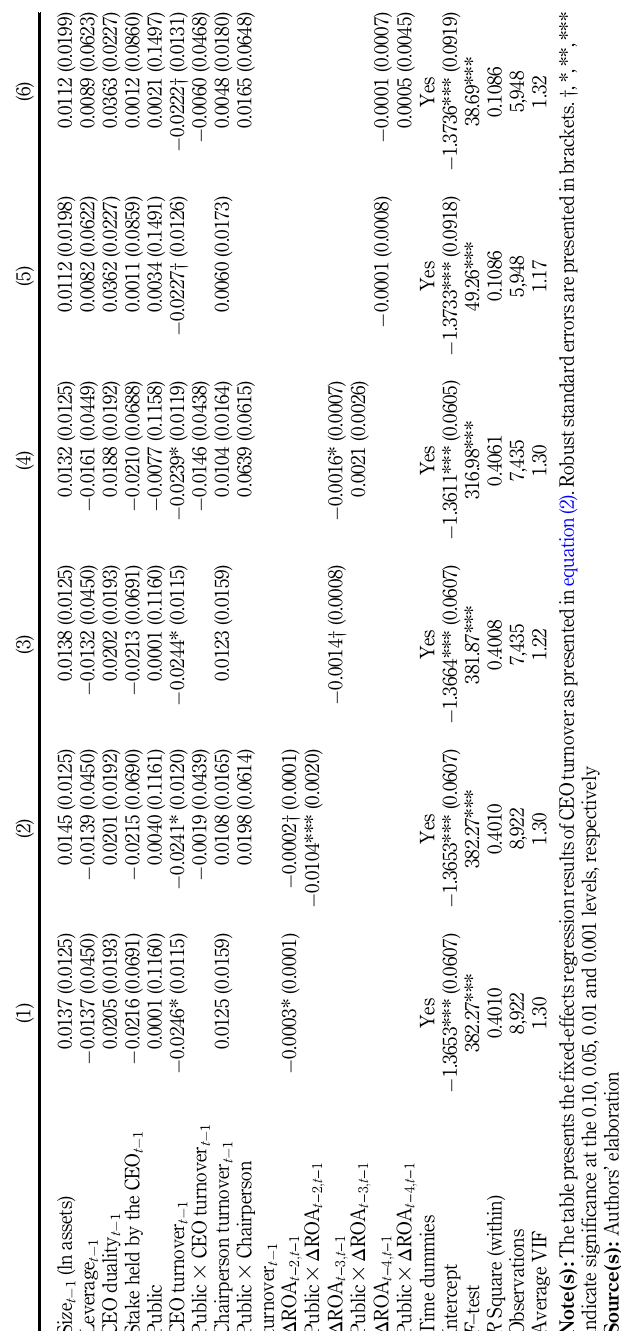
Table 3. CEO turnover in